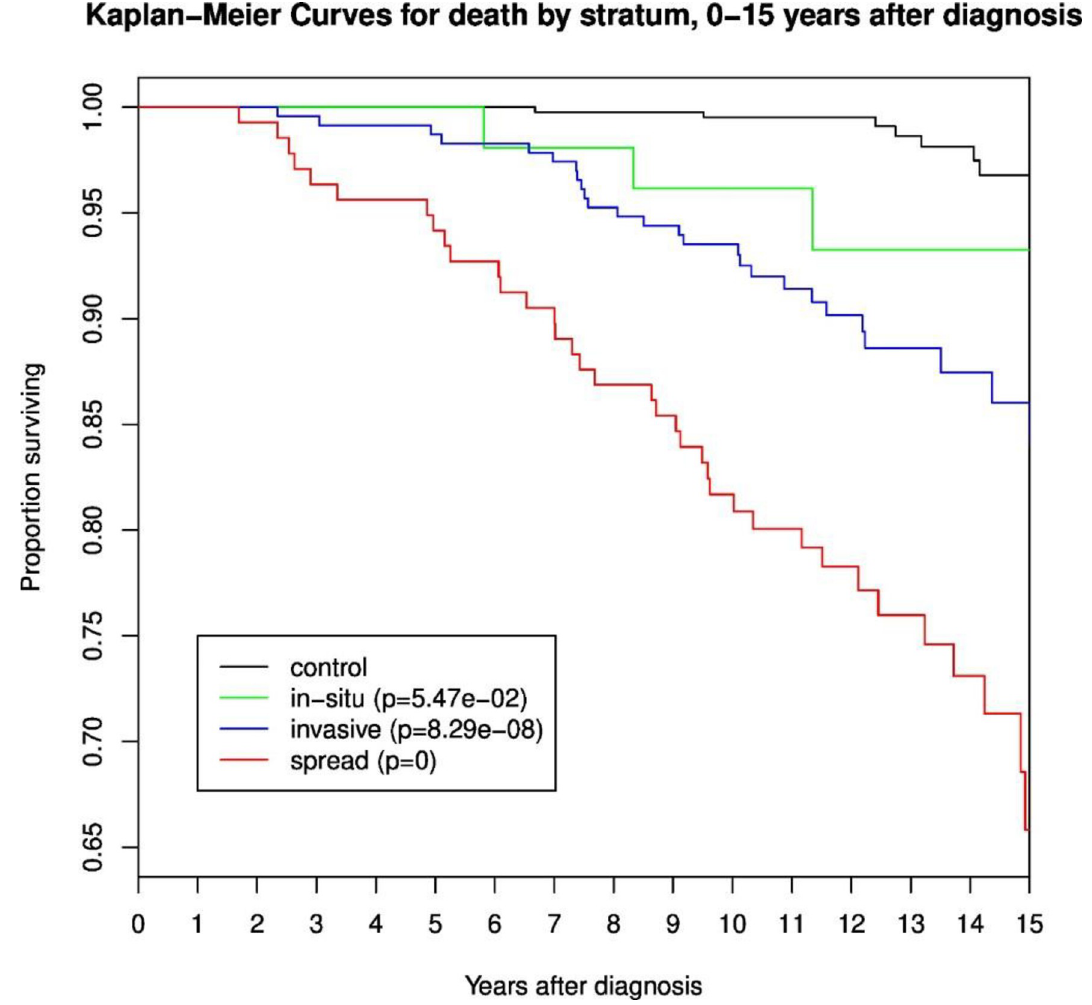
Fig 7. Kaplan-Meier curves for death by stratum. Kaplan-Meier plot for cases and controls in the dataset with up to 15 years of follow-up (metastasis and follow-up time information from the intitial/first breast cancer diagnosis): 52 in situ cases, 232 invasive cases, 137 metastatic